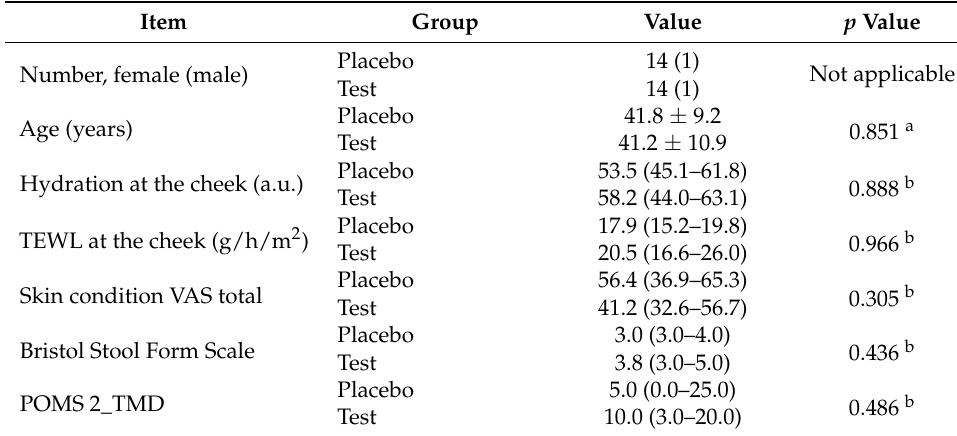
Figure 1. CONSORT flow diagram. Table 4. Background characteristics.